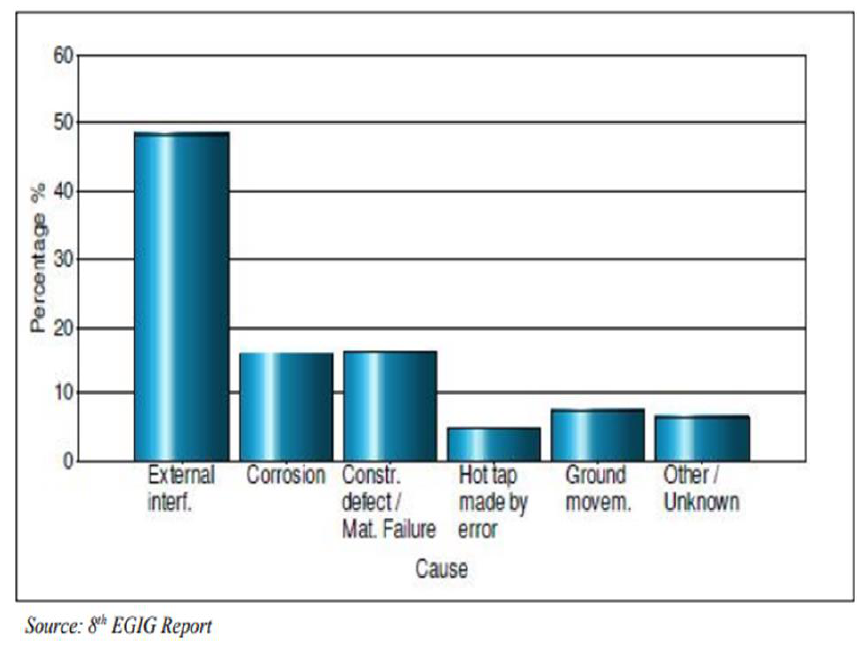
Figure 4. Natural gas pipeline failure—distribution of incident and causes.